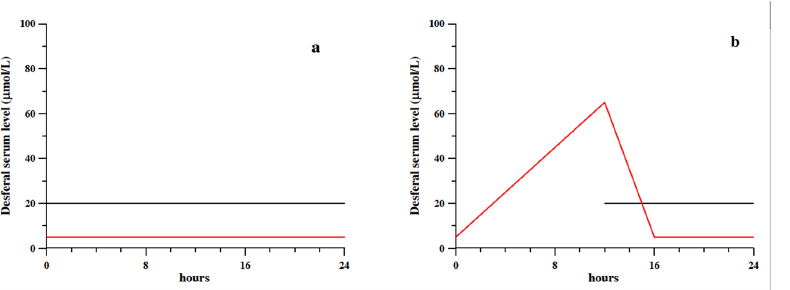
Fig 5. a) Plasma concentration of DFO (continuous line) reproduced on the basis of literature pharmacokinetic data [39] for a dose of 100 mg/Kg in 24 mL, administered at a rate of 1 mL per hour for 24 hours; the concentration of chelatable iron [25] is reported as red line. b) Plasma concentration of DFO (continuous line) for a dose of 100 mg/Kg in 12 mL, administered at a rate of 1 mL per hour for 12 hours. The concentration of chelatable iron [25], reported as red line, takes into account its increase when DFO is not